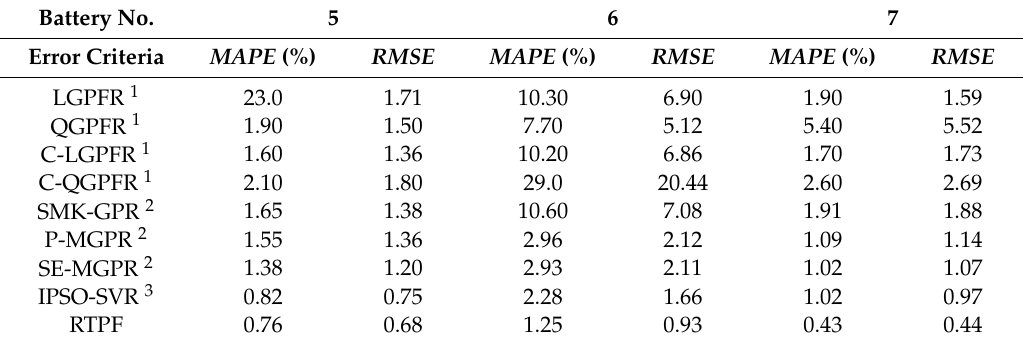
Table 4. Comparison of different prognostic methods for batteries Nos. 5, 6, and 7. RTPF: rest time-based prognostic